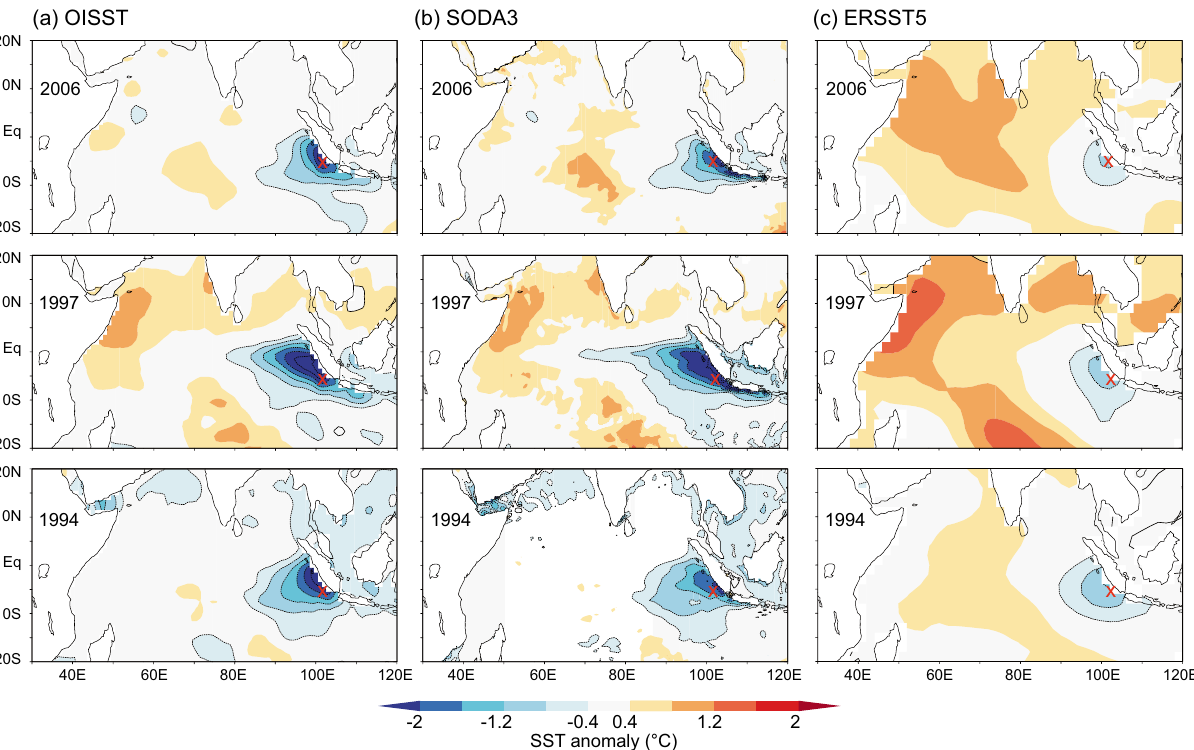
Figure 1. September–November mean SST anomalies during the extreme pIOD events of 2006, 1997 and 1994 as depicted in satellite SSTs (OISST), reanalysis SST (SODA3) and historical SST products (ERSST5). Charts created using the knmi climate explorer (https:// clime xp. knmi. nl/ start. cgi; data accessed 11/03/2022). See text for